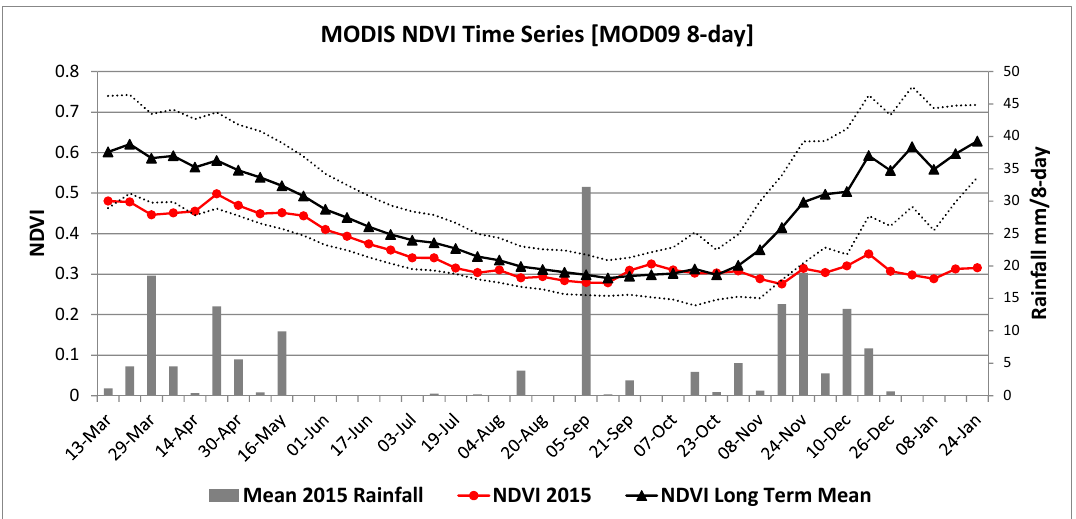
Figure 5. Comparison of the long-term mean MODIS normalized difference vegetation index (NDVI) (2000–2015), 2015 mean MODIS NDVI, and 2015 mean rainfall data for all the Kruger National Park. The dotted black lines show the long-term mean MODIS NDVI ± one standard deviation calculated every eight days 2000–2015. The mean rainfall shows the mean daily rainfall in the eight days corresponding to the eight-day MODIS NDVI periods.